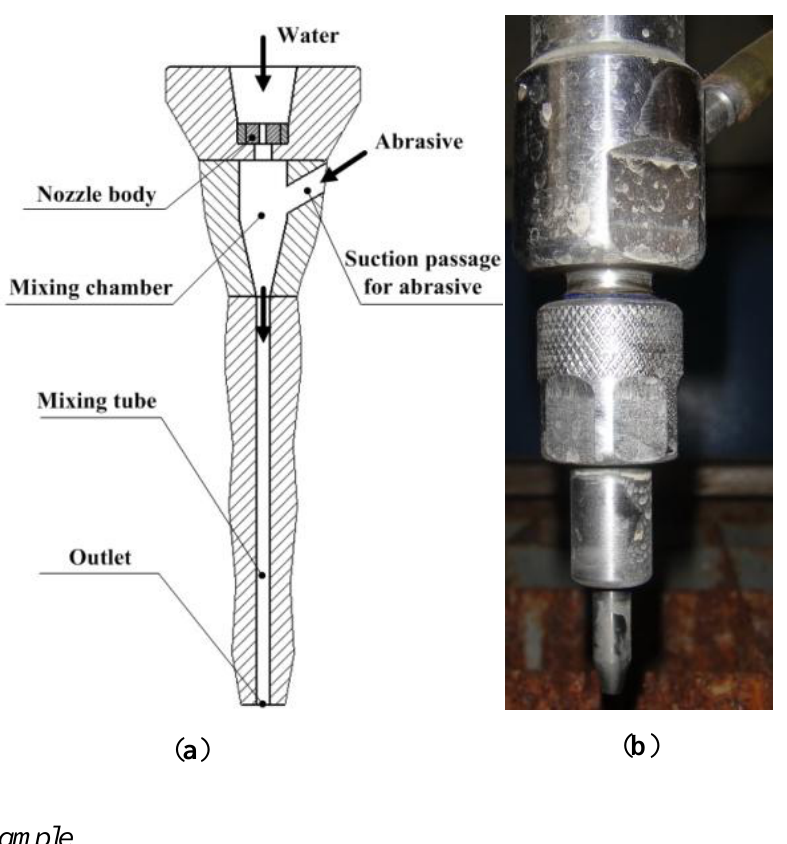
Figure 6. Liquid-solid two-phase jet nozzle. ( a ) Schematic view; ( b ) image of the